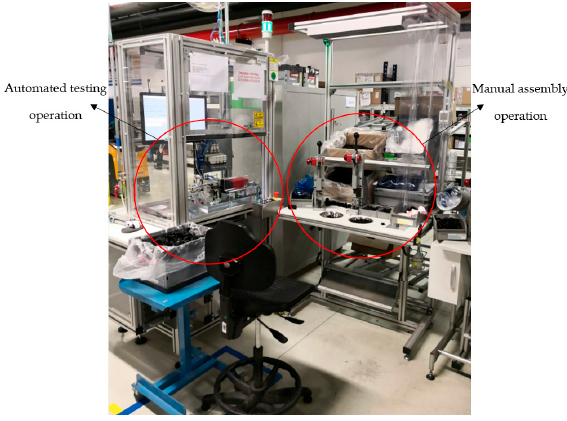
Figure 3. Real-world workplace under consideration.